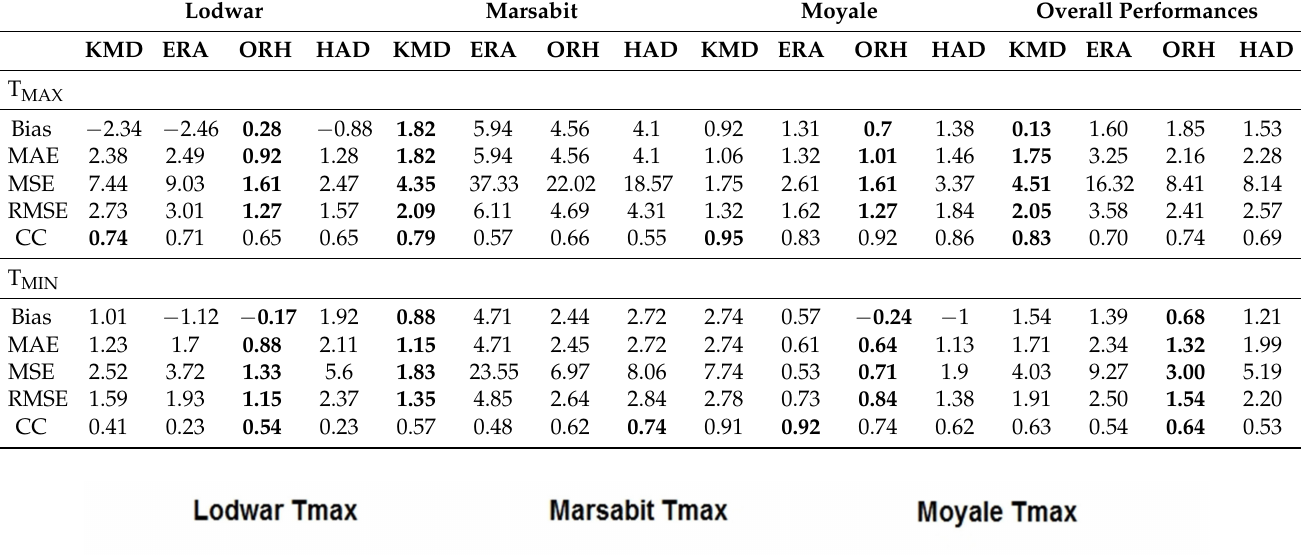
Table 2. Maximum temperature (T MAX ) and the minimum temperature (T MIN ) dataset evaluation, based on statistical coefficient (CC)) computed against the observed historical series selected from the land-based meteorological stations of